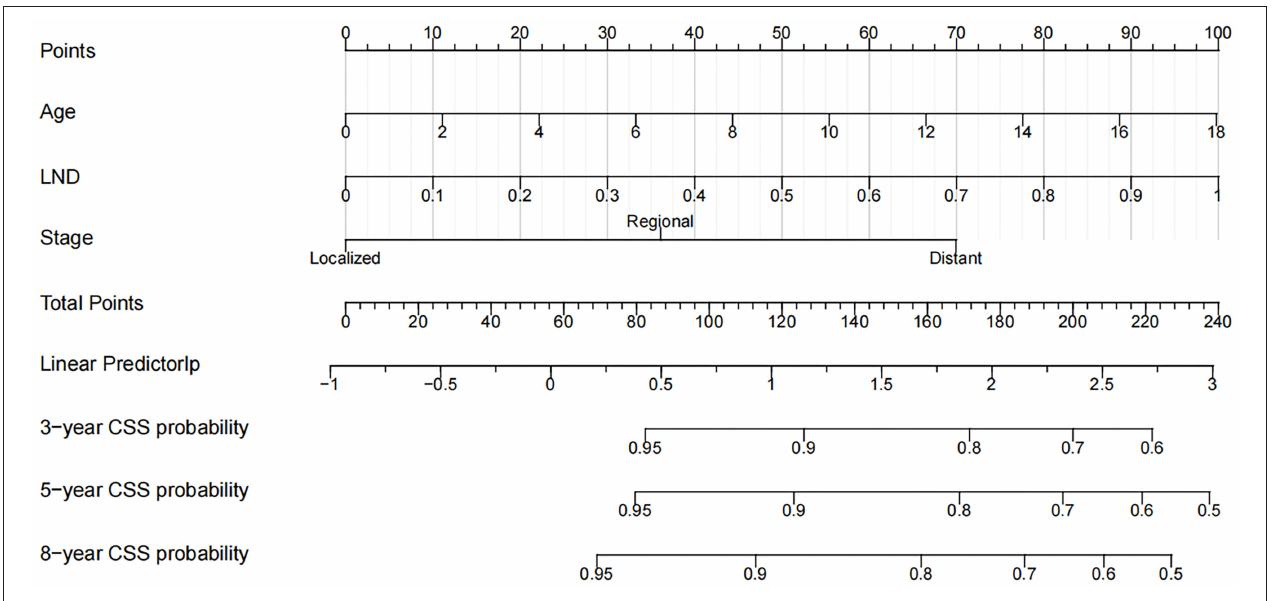
chemotherapy were high-risk factors for the prognosis (27,